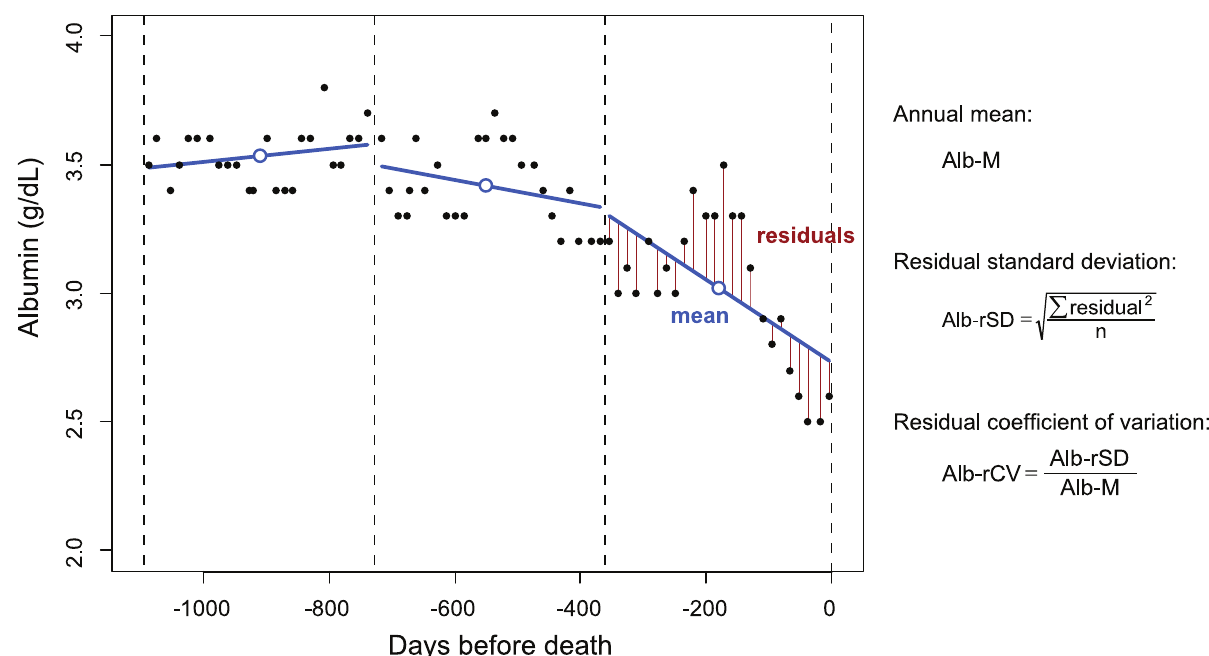
Fig 2. Evaluation of intra-individual albumin variability. The serum albuminvalues in a representative case were plotted over the 3 years before death. The values measuredduringone year were fitted to a linear regressionmodel, and the residual SD and the residual CV were calculatedusing the